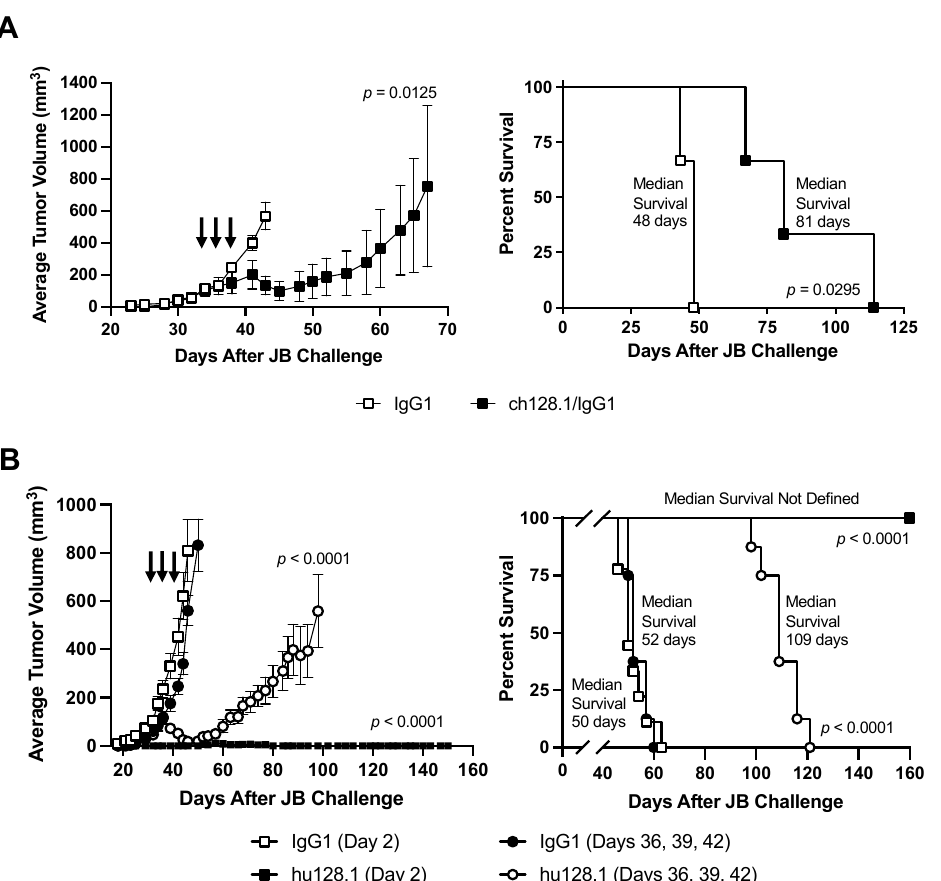
Figure 5. Local model of AIDS-NHL using JB cells. SCID-Beige mice were challenged s.c. with 5 × 10 6 cells in the right flank. ( A ) Once all mice developed palpable tumors (Day 34), mice were distributed by tumor size into two groups ( n = 3 per group). Mice were treated i.v. with either 400 µ g isotype negative control antibody (IgG1) or ch128.1/IgG1 on Days 34, 36, and 38. The tumor growth curves (left panel) and the Kaplan-Meier survival plot (right panel) are shown. Arrows indicate when treatment was given. Individual tumor growth curves are shown in Supplementary Figure S5. ( B ) Mice were treated with 400 µ g isotype negative control antibody (IgG1) or hu128.1 on Day 2, representing an early-stage tumor model ( n = 9 per group). For a late-stage tumor model, mice that were treated once all developed palpable tumors ( n = 8 per group). Mice were then grouped by tumor size and treated i.v. with either 400 µ g isotype negative control antibody (IgG1) or ch128.1/IgG1 on Days 36, 39, and 42. The tumor growth curves (left panel) and the Kaplan-Meier survival plot (right panel). Arrows indicate when treatment was given. Individual tumor growth curves are shown in Supplementary Figures S5 and S6. For both panels, the growth curves reflect the time when all animals in the treatment group were alive. The tumor growth curves indicate the average tumor volume with the SEM for each treatment